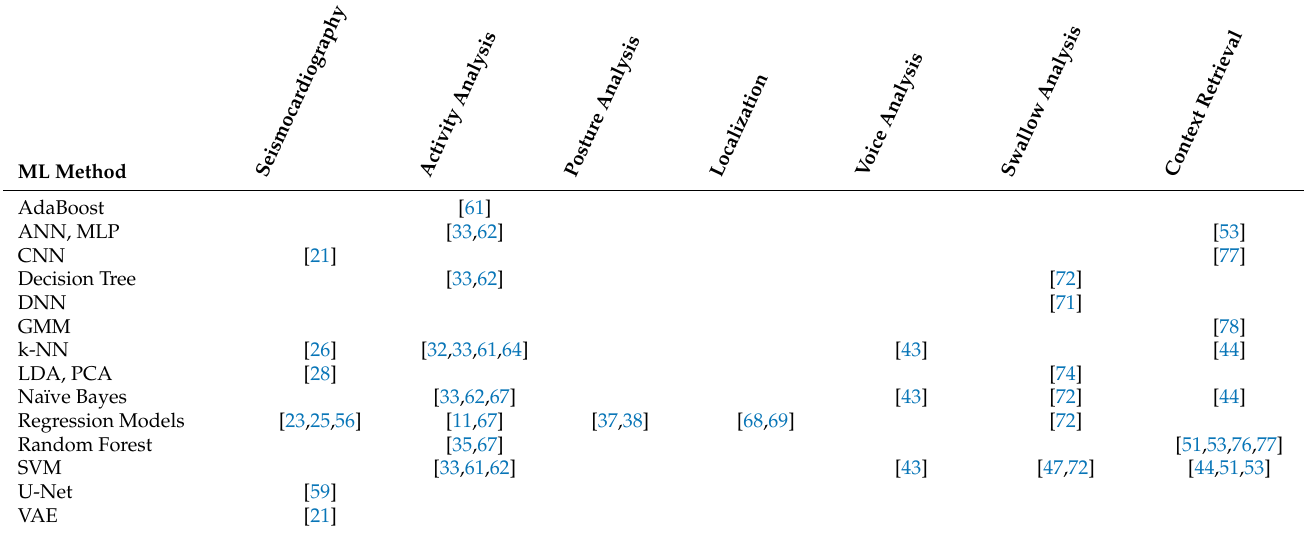
Table 8. Machine learning methods used in the referenced studies versus application area. Acronyms used in this table: AdaBoost—Adaptive Boosting; ANN—Artificial Neural Network; CNN—Convolutional Neural Network; DNN—Deep Neural Network; GMM—Gaussian Mixture Model; k-NN—k-Nearest Neighbor; LDA—Linear Discriminant Analysis; ML— Machine Learning; MLP—Multilayer Perceptron; PCA—Principal Component Analysis; SVM—Support Vector Machine; VAE—Variational Autoencoder.